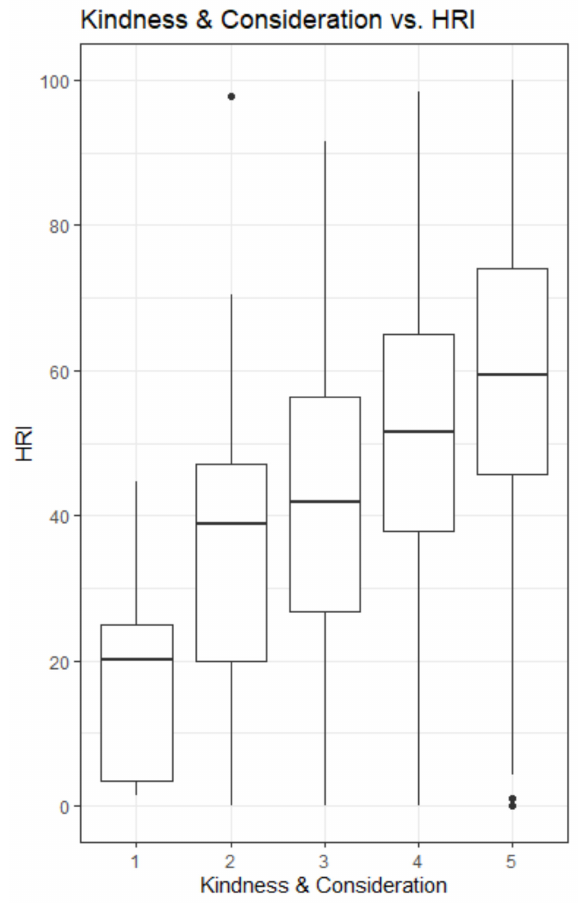
Figure 2. In the overall sample ( n = 755), respondents who were not being treated with kindness and consideration by one’s supervisor had a lower HRI than respondents who were being treated with kindness and consideration by one’s supervisor (md = 20.1 and md = 59.3). Table 3. Work environment-related production loss at